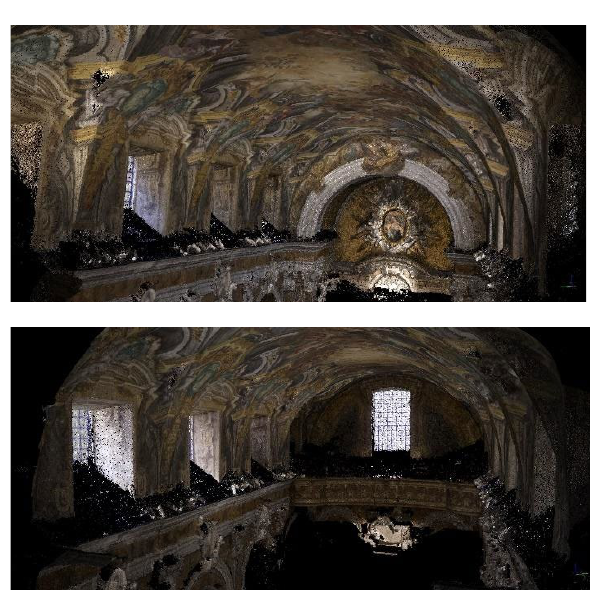
Figure 4. Photogrammetric point cloud